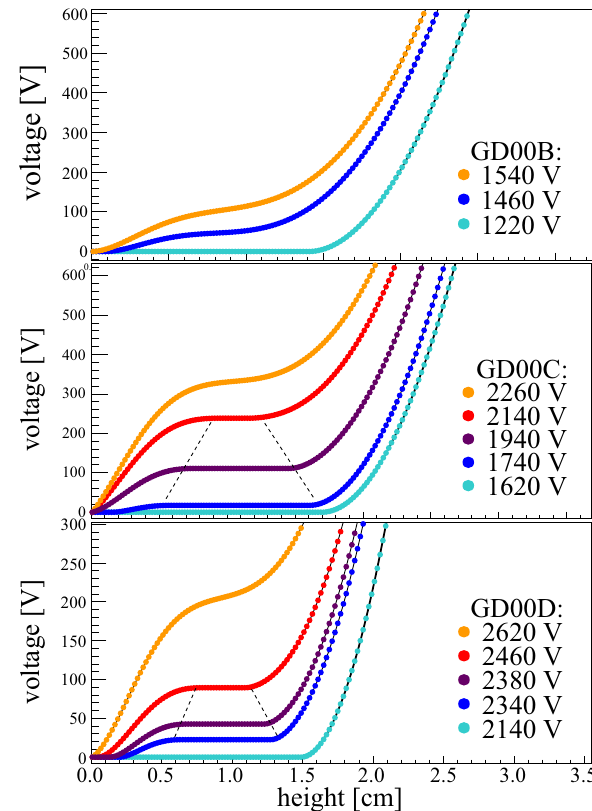
Fig. 5 ADL3 -simulation of the electrical depletion process of the detectors GD00B, GD00C and GD00D: the voltage along the central axis starting at the p+ electrode read-out is depicted as function of the voltage applied externally to the n+ contact. The curves in orange rep- resent the voltage when the full depletion is reached. Curves with an intermediate constant interval are marked with a dotted line and corre- spond to voltages, at which a ‘bubble’ persists. For experimental data see Figs. 3 and